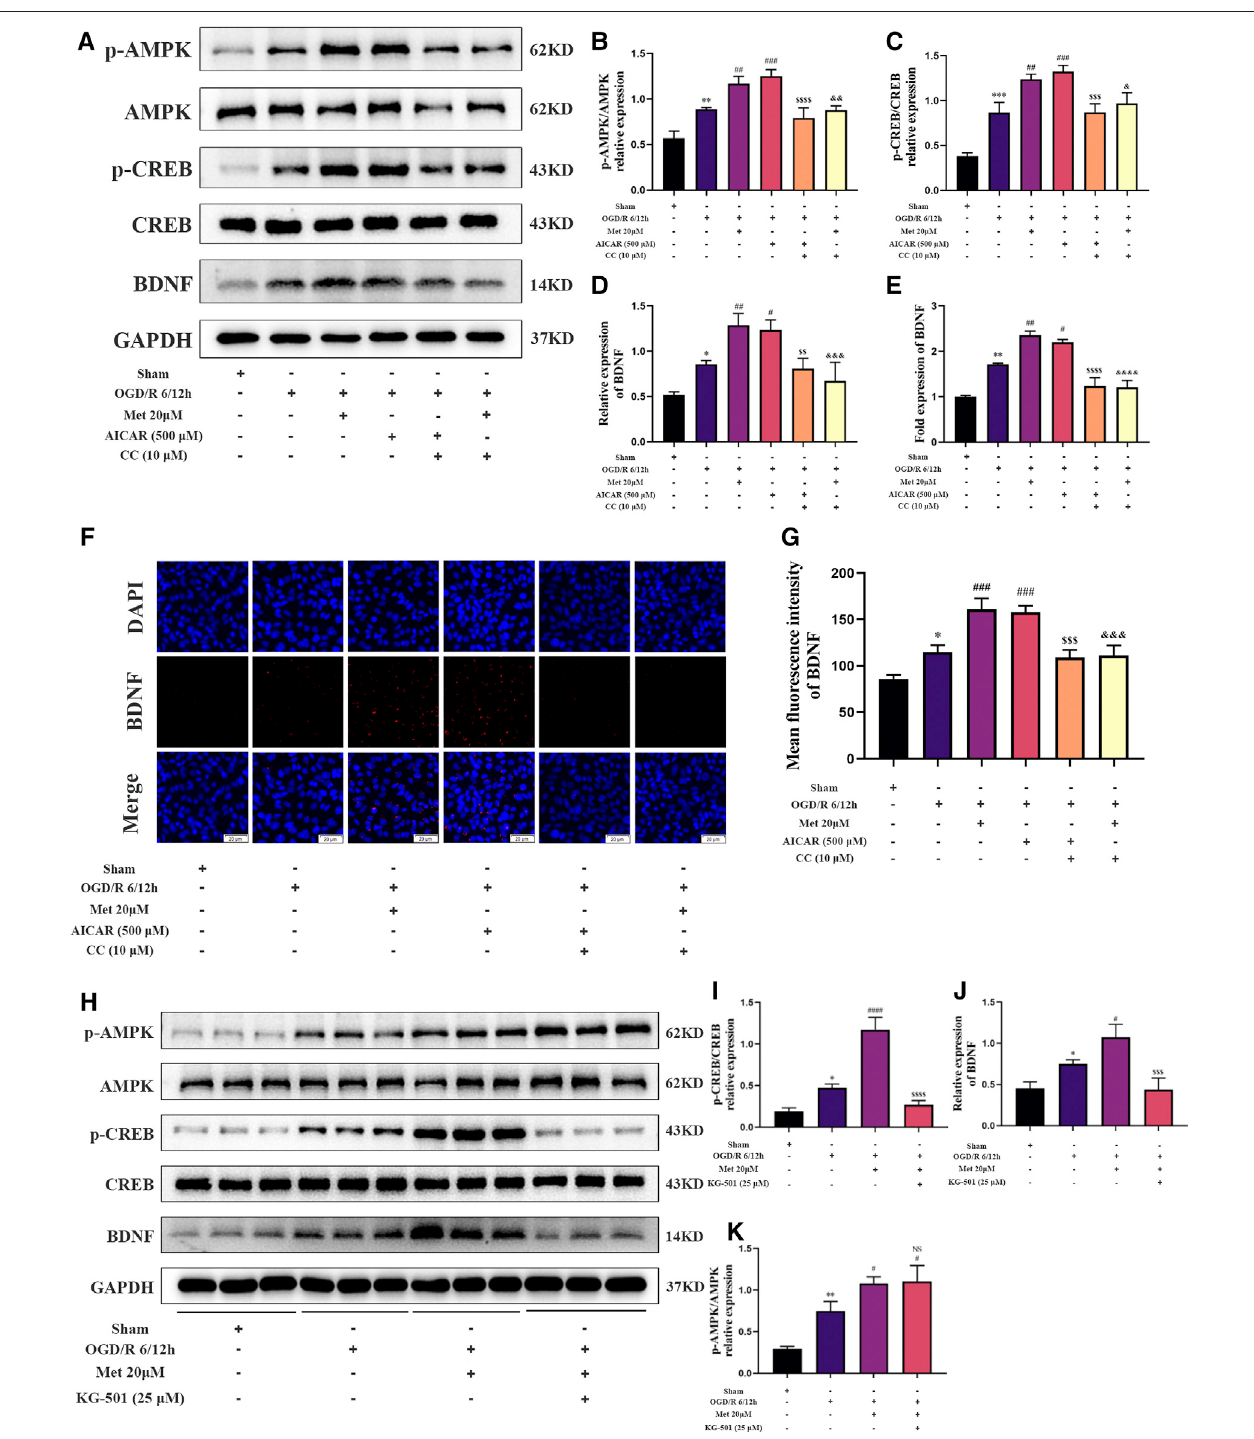
FIGURE 6 | Metformin promotes the expression of BDNF in HUVECs under OGD/R conditions through the AMPK/CREB pathway. (A – D) The BDNF expression level and AMPK and CREB phosphorylation levels in HUVECs treated with metformin, AICAR, and Compound C under OGD/R conditions detected were by western blotting ( n = 3). (E) The BDNF transcription level under the above conditions wasdetected byRT-qPCR (n= 4). (F,G) Immuno fl uorescence stainingand quanti fi cation of BDNF under the above conditions ( n = 3, bar = 20 μ M). (H – K) BDNF expression level and AMPK and CREB phosphorylation levels in HUVECs treated with metformin and KG-501 under OGD/R conditions were detected by western blotting ( n = 3). (* p < 0.05, ** p < 0.01, *** p < 0.001 vs. sham; # p < 0.05, ## p < 0.01, ### p < 0.001, #### p < 0.0001 vs. OGD/R6/12 h; NS, not signi fi cant, $$ p < 0.01, $$$ p < 0.001, $$$$ p < 0.0001vs. OGD/R 6/12 h +AICAR; & p < 0.05, && p < 0.01, &&& p < 0.001, &&&& p < 0.0001 vs. OGD/R 6/12 h + Met 20 μ M).